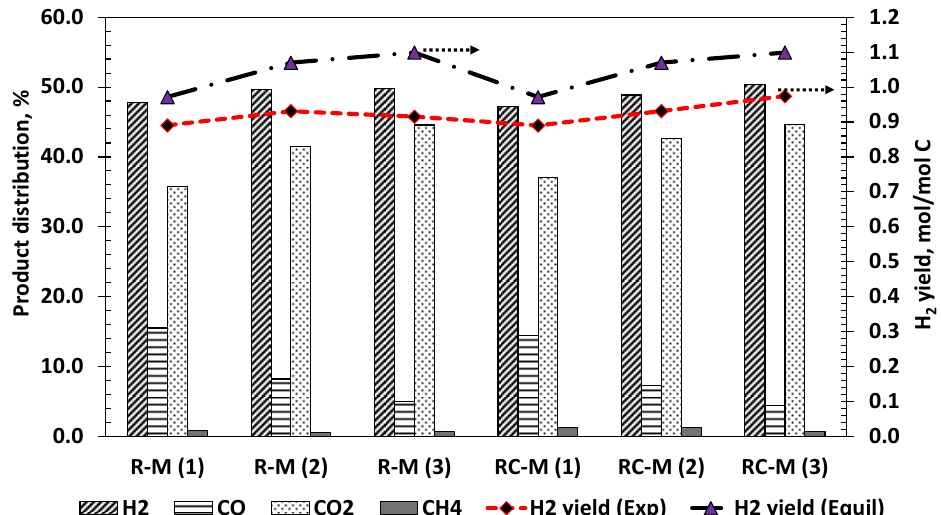
Figure 8. Product distribution and H 2 yield obtained during ATR of HAc flowing at 2 mL/h, S/C shown in brackets = 1,2,3, and equivalence ratio λ = 0.353 (Air flow = 43.3 mL/min), hot product gas at 570 °C and 1 bar.